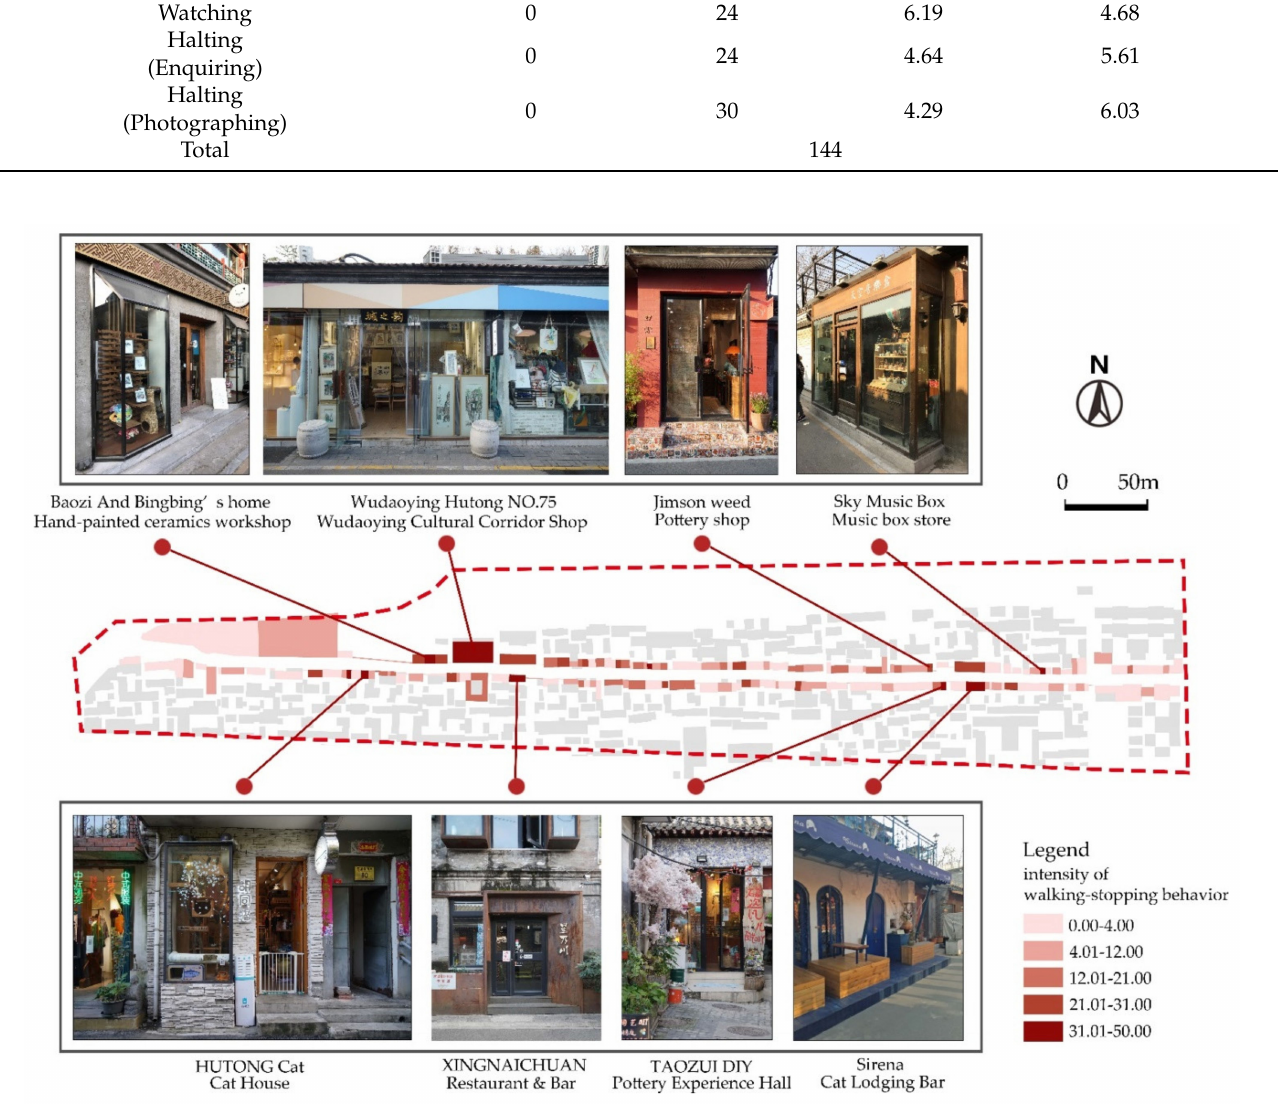
Figure 6. Intensity distribution of walking-stopping behaviors measured by each building unit alongside the Wudaoying